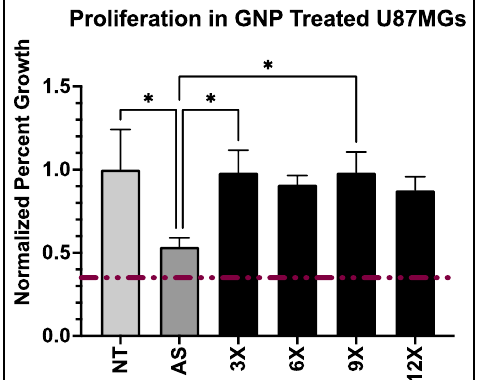
Figure 5. Proliferation activity, measured by cell viability, within U87MGs post-treatment with bare 4 nm GNPs representing maximal gold concentrations present within the solution for each particle type. * represents p < 0.05. The red line indicates the normalized initial cell seeding value.